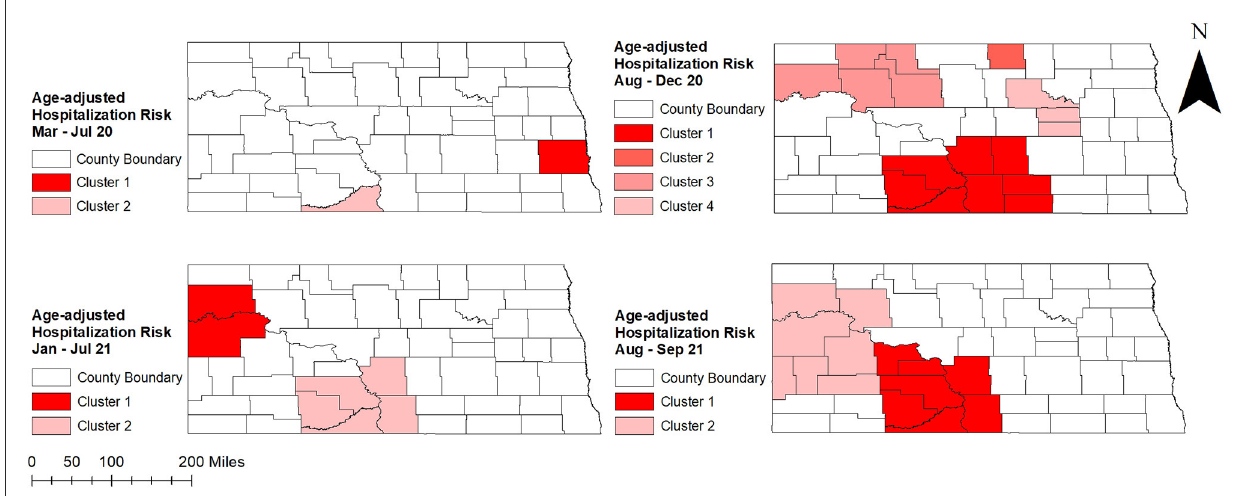
FIGURE6 Spatial clusters of age-adjusted high COVID-19 hospitalization risks identified in North Dakota using Kulldorff’s circular spatial scan statistics, March 2020–September 2021.